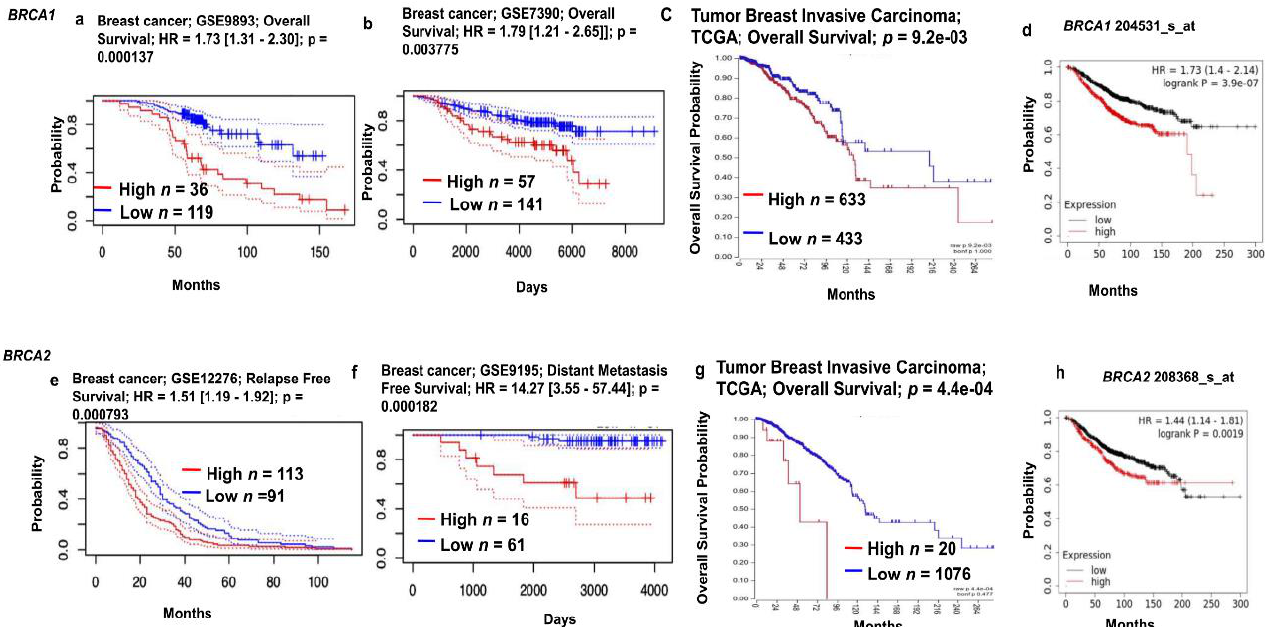
Figure 4. Relationship between BRCA1/2 mRNA expression and clinical outcomes in breast cancer patients (PrognoScan Database, R2: Kaplan Meier Scanner and Kaplan–Meier Plotter). ( a , b , e , f ) The survival curve comparing the patient with high (red), and low (blue) expression of BRCA1/2 was plotted from the PrognoScan database (http://dna00.bio.kyutech.ac.jp/PrognoScan/, accessed on 10 February 2022) in breast cancer patients. The threshold of cox p value < 0.05. ( c , g ) The survival curve comparing the patient with high (red) and low (blue) expression of BRCA1/2 was plotted from R2: Kaplan Meier Scanner (https://hgserver1.amc.nl/cgi-bin/r2/main.cgi, accessed on 10 February 2022) in TCGA breast cancer patients. The threshold of cox p value < 0.05. ( d , h ) The survival curve comparing the patient with high (red) and low (black) expression of BRCA1/2 was plotted from Kaplan–Meier Plotter (https://kmplot.com/analysis/, accessed on 10 February 2022) in breast cancer patients. The threshold of cox p value < 0.05.